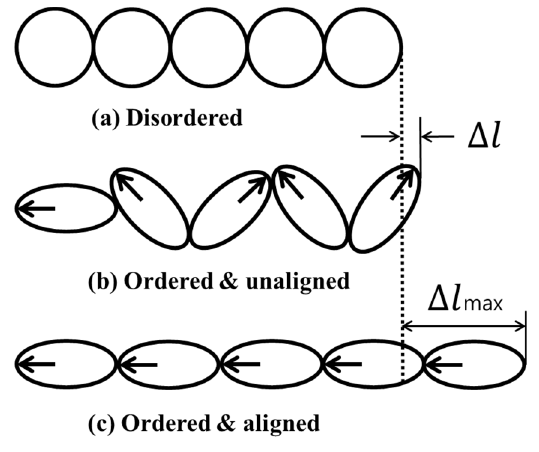
Figure 2. Magnetostriction: ( a ) disordered, ( b ) ordered & unaligned, ( c ) ordered & aligned.